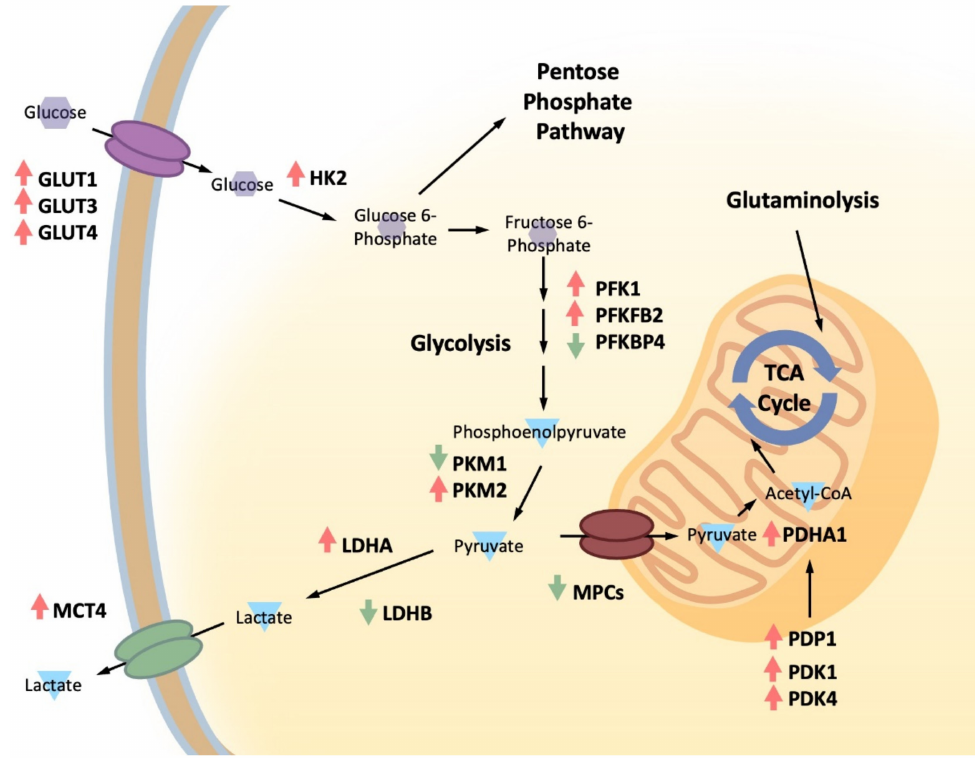
Figure 2. Altered glucose metabolism and the reported aberrations that help facilitate an increased glycolytic phenotype in aggressive PCa